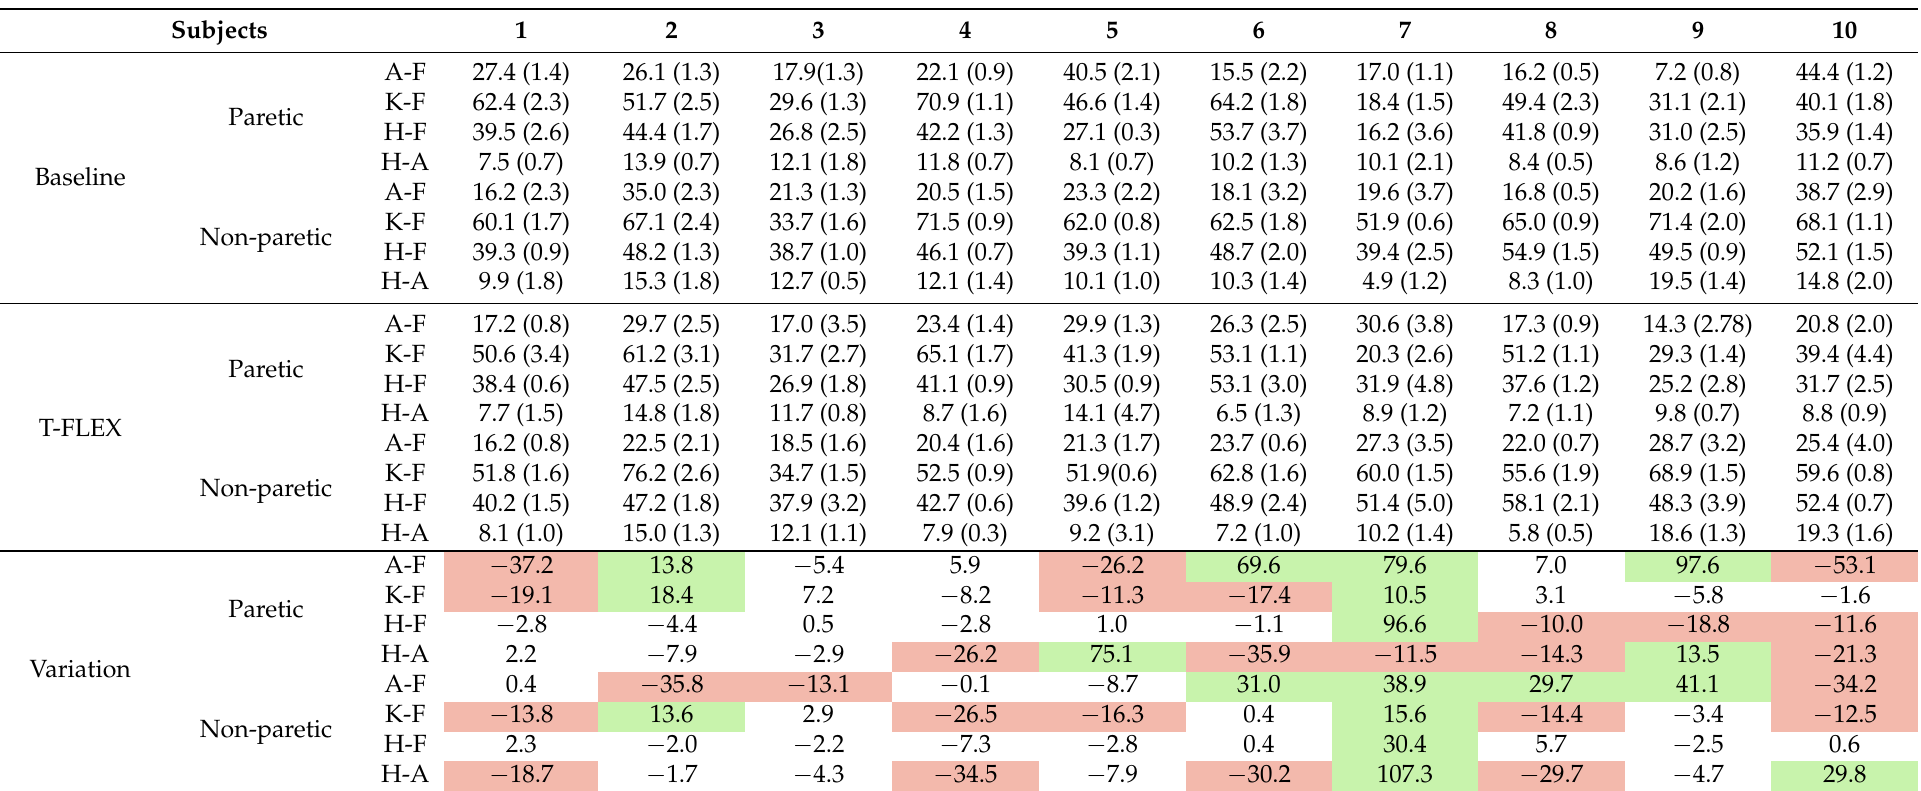
Table 2. Range of motion on the participants’ lower limb joints in the proposed scenarios (i.e., baseline and T-FLEX). The analyzed movements comprise Flexo-extension on the Ankle, Knee, and Hip joints (A-F, K-F, and H-F, respectively). Moreover, it also includes the Adduction-Abduction on the Hip (H-A). Values in parenthesis represent the standard deviation. The lower part shows the percentage of variation on the joints when the participant used the T-FLEX’s actuation system. The positive values refer to increases in this value in contrast with the negative values, which indicate decreases. The highlighted values indicate significant joint changes greater than 10% for both increases (green) and decreases